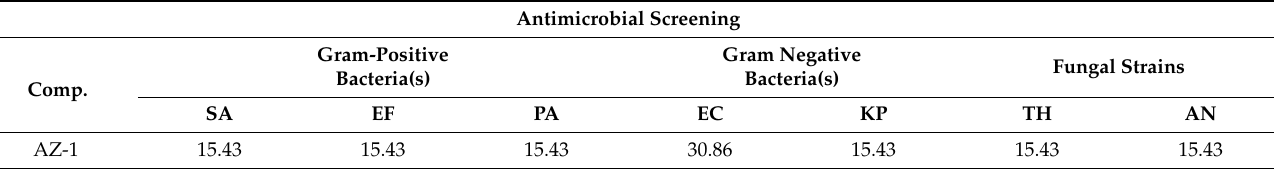
Table 2. Antimicrobial screening ( µ M) of (substituted)-1,3,4-oxa/thia-diazol-2-yl)-3-chloro-4-(substituted) azetidin-2-one